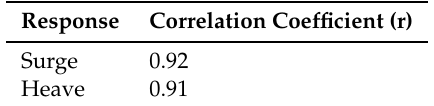
Table 4. Correlation coefficient for results